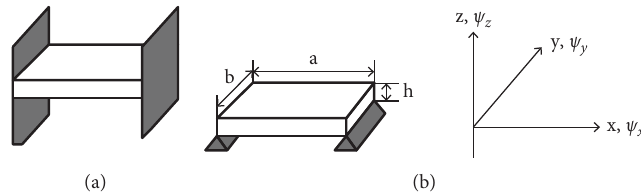
Figure 1: Schematic diagram of a rectangular microplate: (a) clamped-clamped (CC) and (b) simply supported (SS) boundary